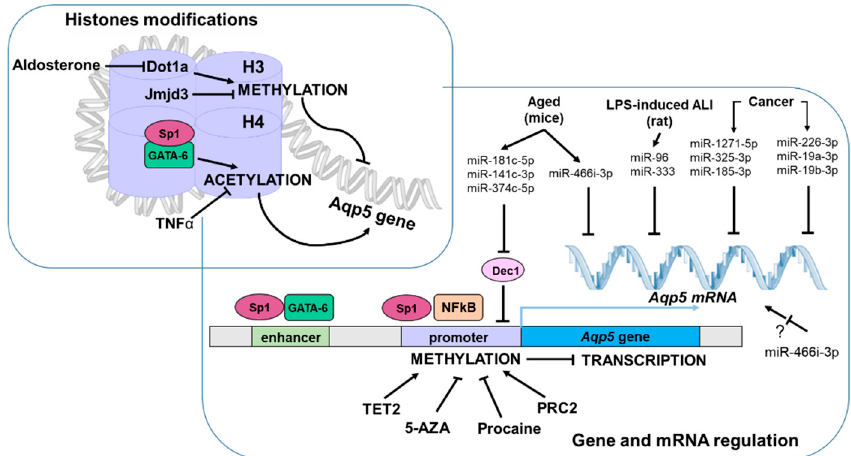
Figure 2. Epigenetic modifications regulating Aqp5 transcription. Synoptic view of known epige- netic regulation of Aqp5 expression across different cell types and medical conditions. 5-AZA: